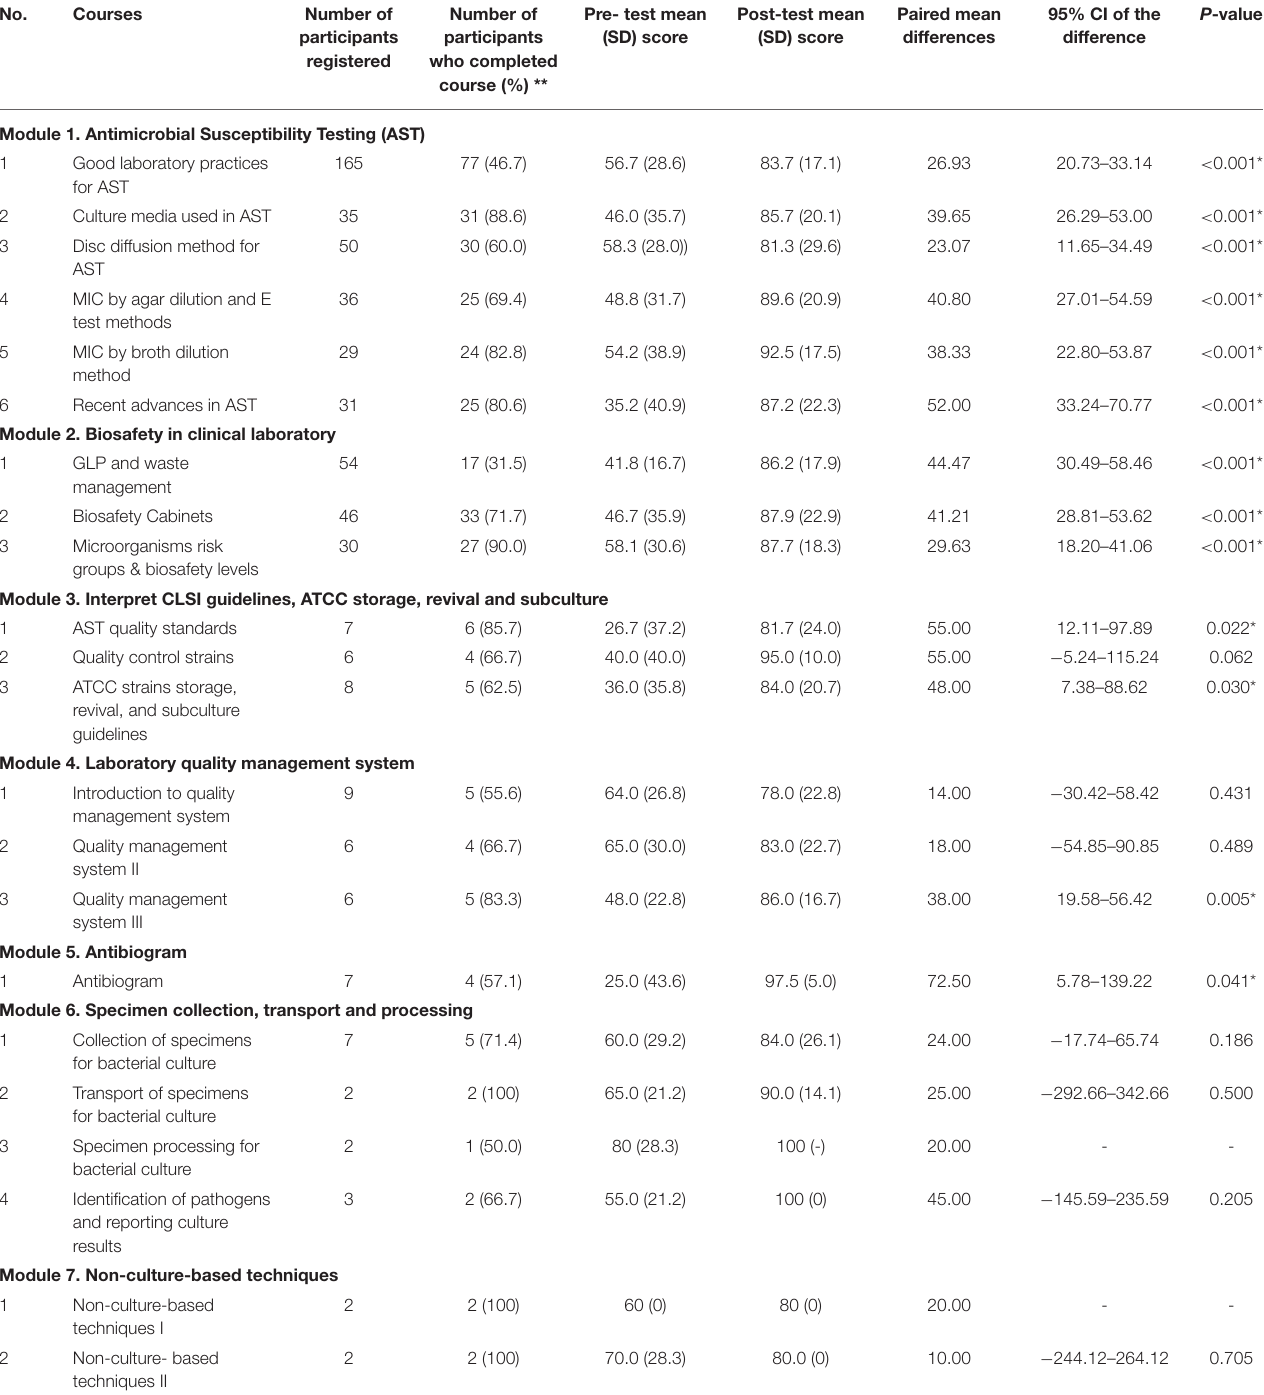
TABLE 2 | Enrolment frequency and completion rates for different courses and an improvement in pre- and post-course test scores among different courses are shown below. No.